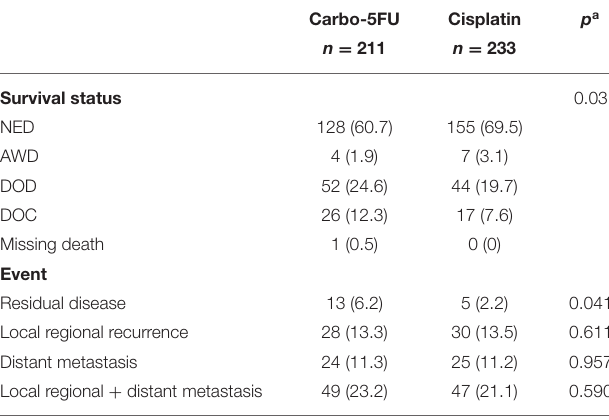
TABLE 4 | Disease and survival status of patients at the time of analysis.